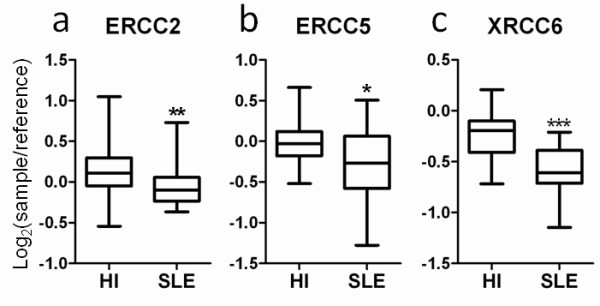
Decrease in the expressions of three DNA repair genes. The expression levels of (a) excision repair cross-complementing (ERCC)2, (b) ERCC5, and (c) X-ray repair cross-complementing (XRCC)6 in peripheral blood of 21 patients with systemic lupus erythematosus (SLE) and 45 healthy individuals (HI) are shown. All data represent microarray data with the expression values of log2(sample/reference). *P < 0.05, **P < 0.01, ***P < 0.001 (unpaired Mann-Whitney test) for 21 SLE patients versus 45 HI. Boxes contain the 50% of values falling between the 25th and 75th percentiles, the horizontal line within the box represents the median value, and the whiskers are the lines that extended from the box to the highest and lowest values, excluding outliers.